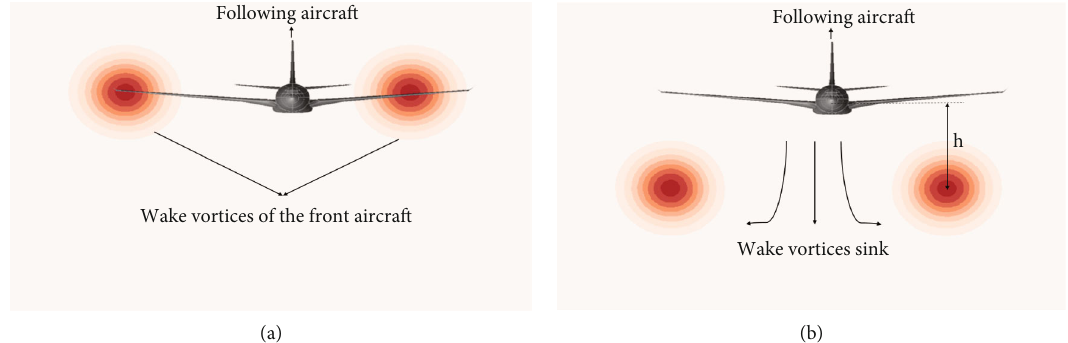
Figure 11: Two scenarios of the following aircraft encountering the wake of the front aircraft.